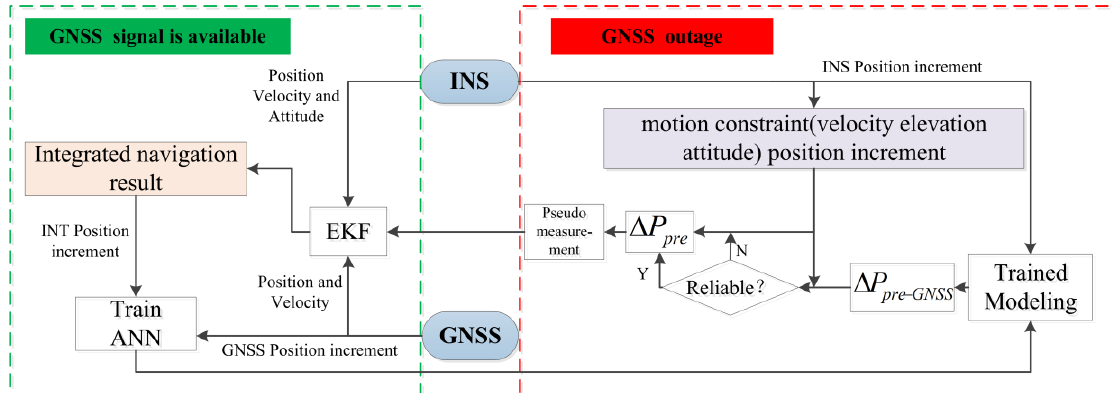
Figure 5. Flowchart of the proposed method.